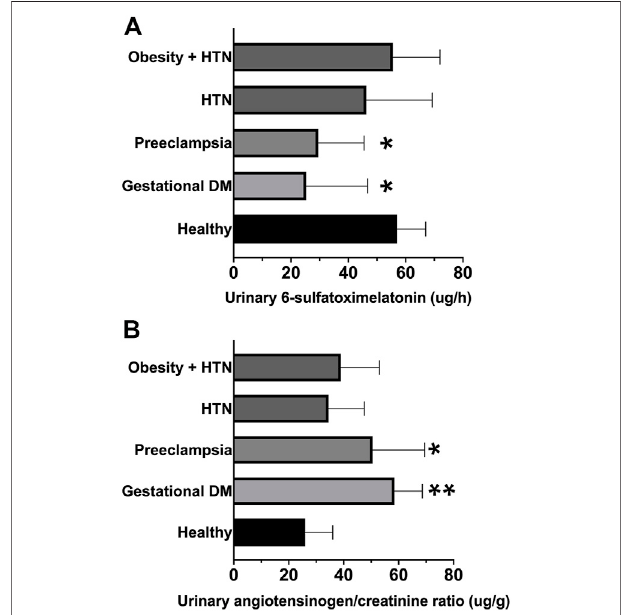
FIGURE 3 | (A) Urinary 6-sulfatoxymelatonin (ug/h) in fi rst morning void urine samples. (B) Urinary angiotensinogen-creatinine ratio (ng/mg). Graphs areranksplotswithbarsofmedianwithinterquartilerange;Kruskal – Wallistest *, p < 0.05 and **, p < 0.005 in comparison to the healthy